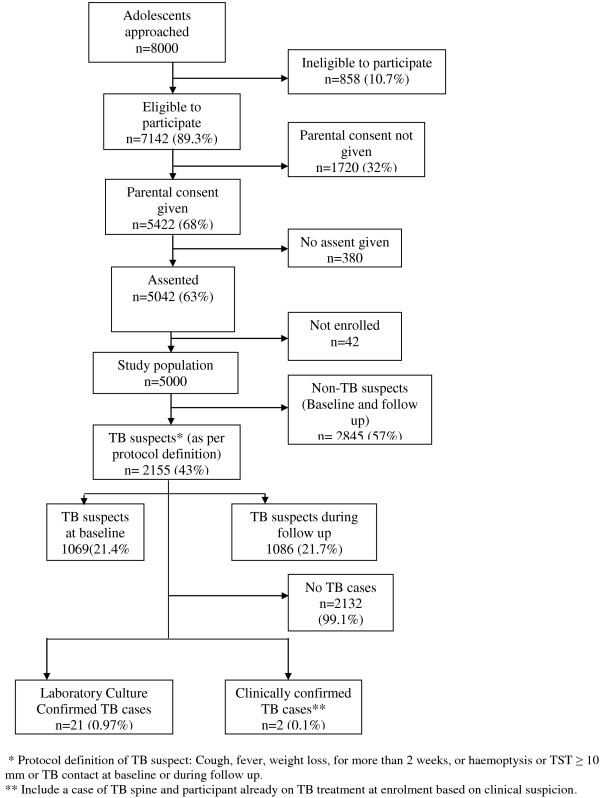
Study profile and TB cases among adolescents in a rural cohort in eastern Uganda.